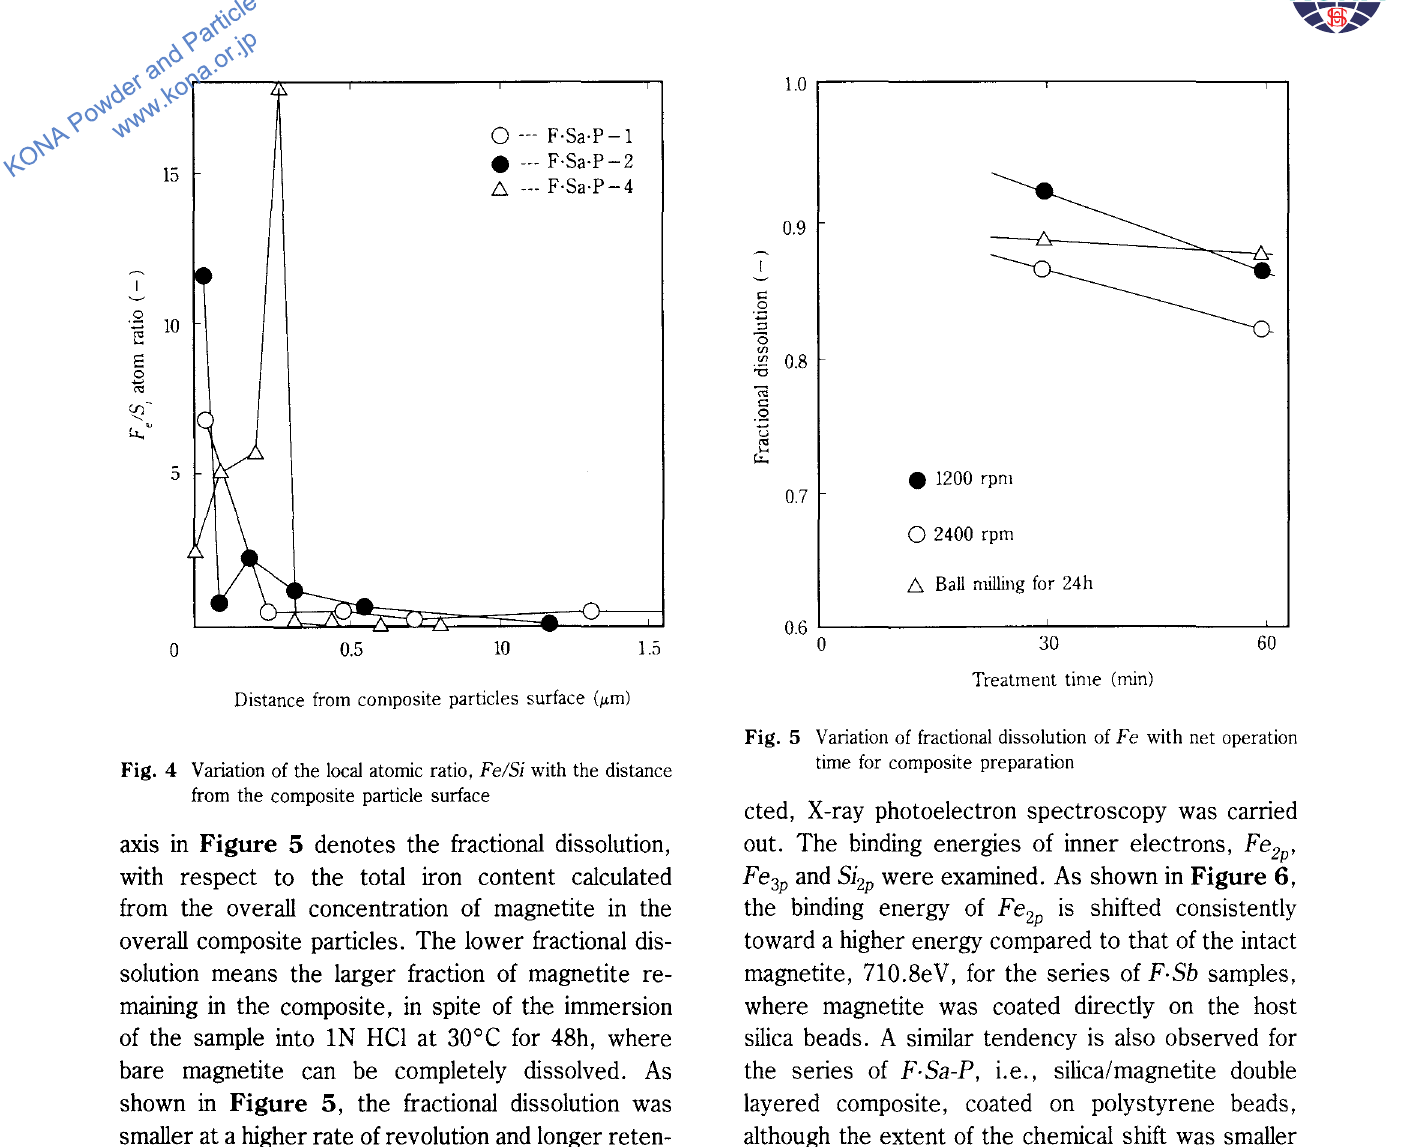
Fig. 5 Variation of fractional dissolution of Fe with net operation time for composite